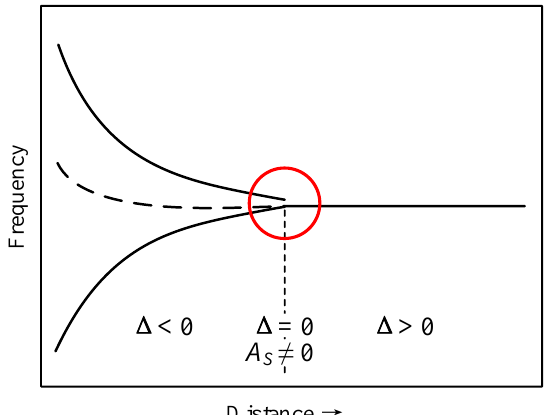
Figure 5. Operating frequency versus distance between the Tx and Rx coils at complete matching (when Δ = 0, A S ≠ 0).